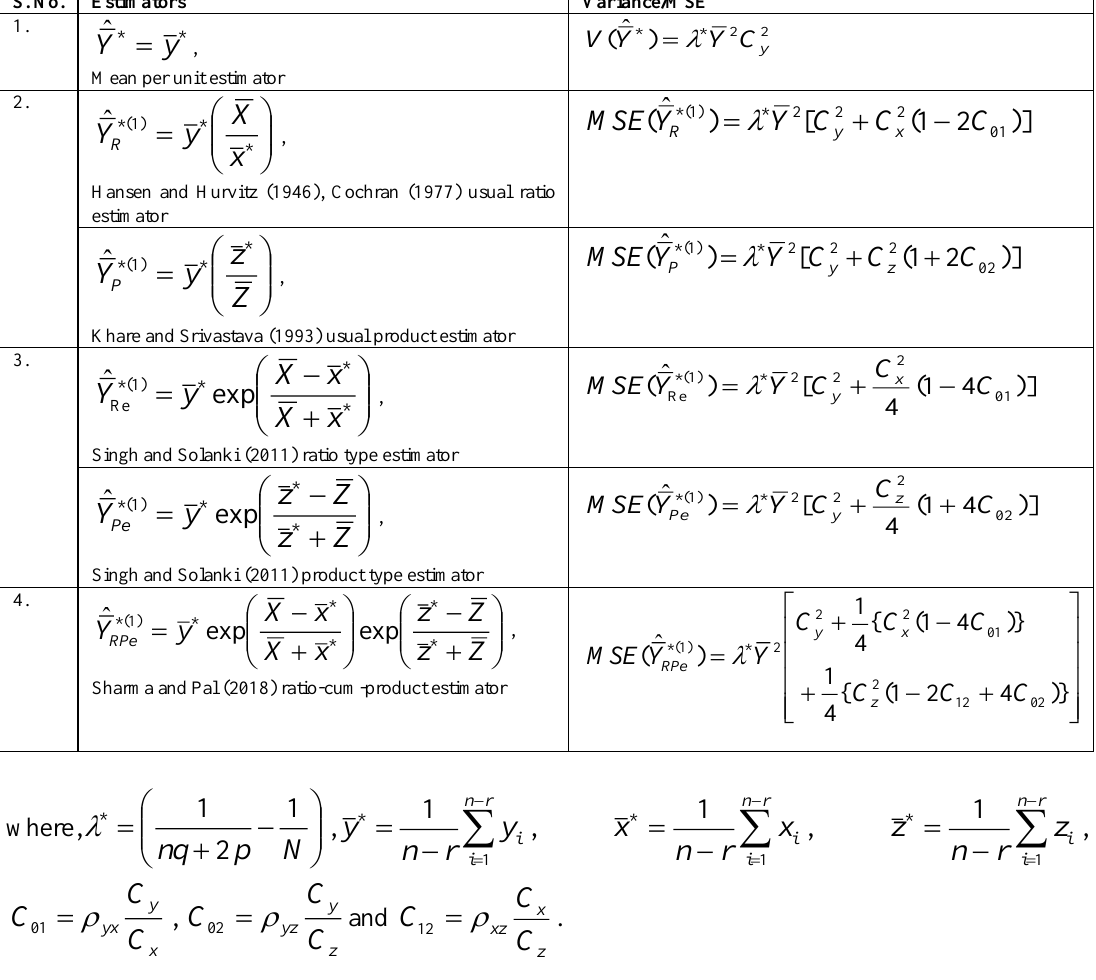
Table 1. Competing estimators under first strategy of non-response along with their MSEs S.